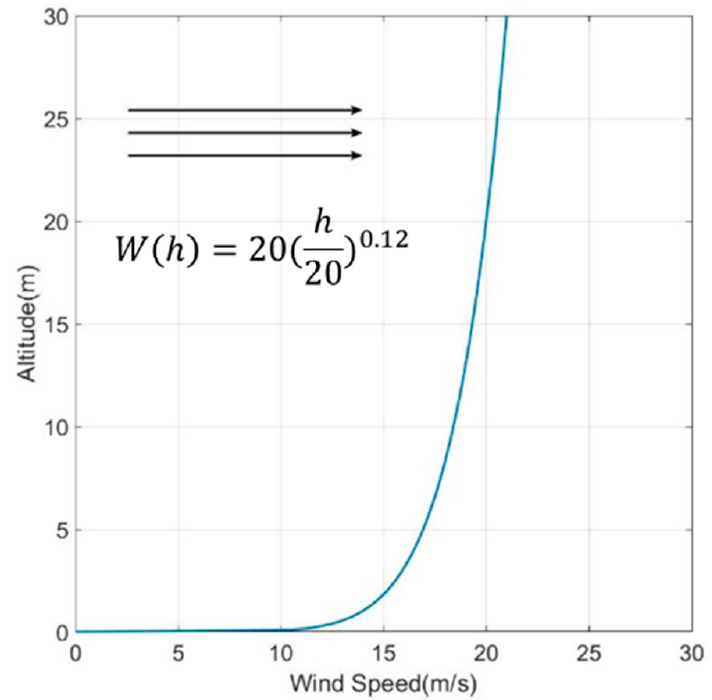
Figure 4. The exponential wind field model.